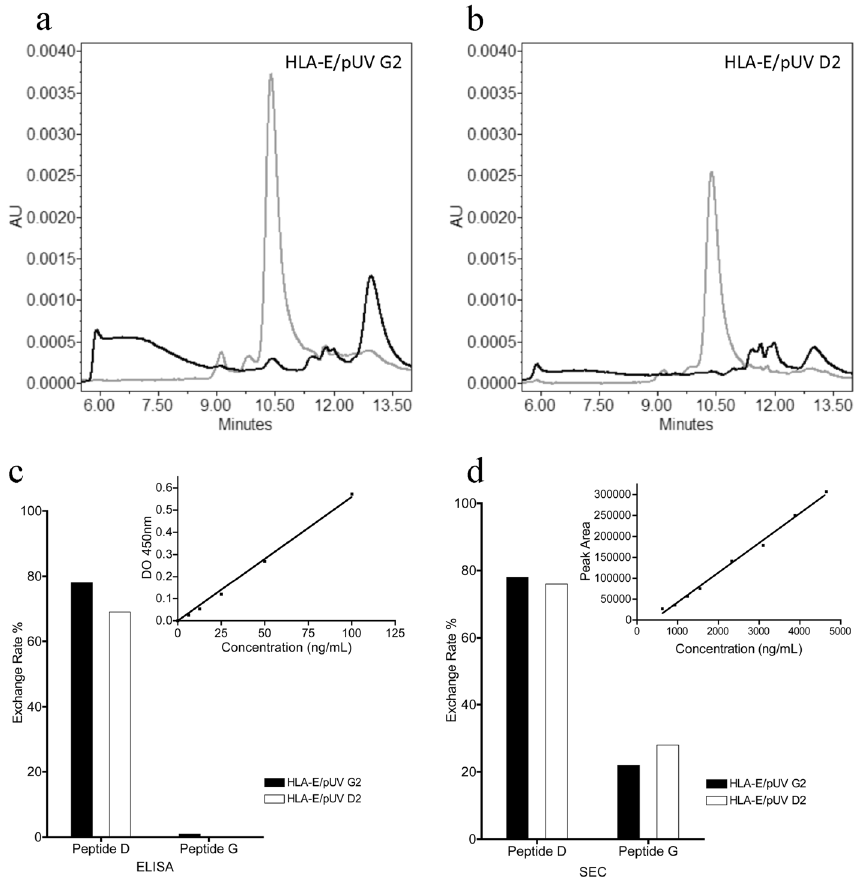
Figure 4. Gel filtration HPLC profiles of HLA-E/pUV complexes and comparison of neo-complex formation by ELISA and SEC quantification. Monomers were injected onto an X-Bridge BEH200Å size exclusion column and detected by absorbance at 280 nm. ( a ) Profiles obtained for the photosensitive HLA-E/pUV D2 monomer without (grey curve) or after UV exposure without rescue peptide (black curve). ( b ) Same results with the photosensitive HLA-E/pUV G2 monomer. The photosensitive HLA-E/pUV D2 and HLA-E/pUV G2 monomers were tested for their ability to form complexes with other peptides either by ELISA test ( c ) or by SEC analysis ( d ). The photosensitive monomers were exposed for 1 h at 355 nm in the presence of the native D peptide or G peptide. Exchange rates were calculated from calibration curves obtained by injecting increasing concentrations of HLA-E/Peptide D monomer produced in batch protocol (see inset for each